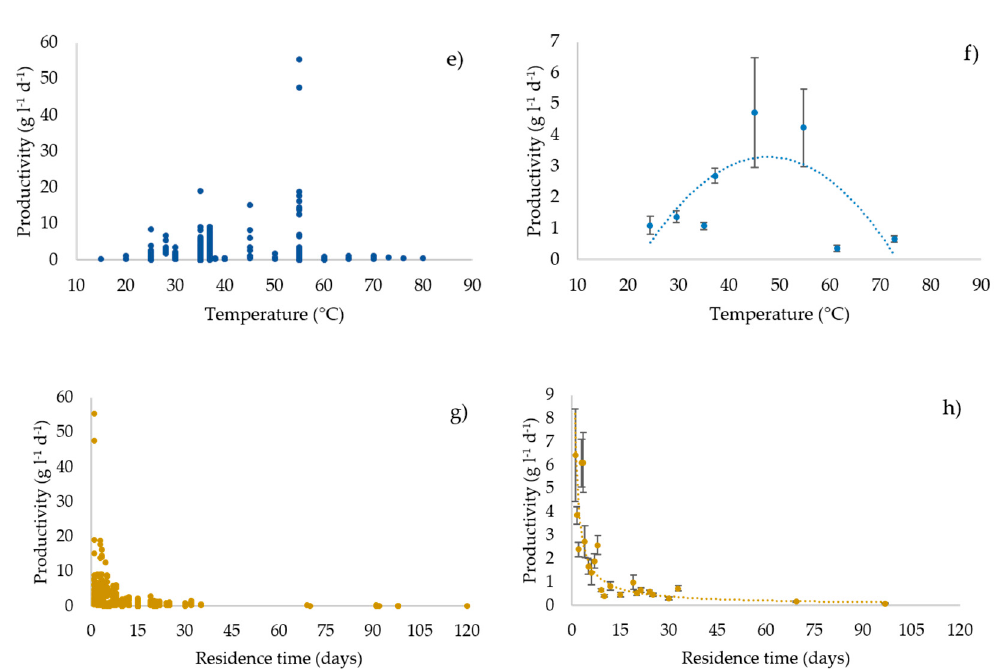
Figure 3. Relationships between productivity and operating parameters. ( a , c , e , g ) All the considered experiments. ( b , d , f , h ) Average values of experiments in each narrow range (width maximum 20%) of the operating parameters (error bars indicate the standard error) with second grade polynomial curve. The polynomial curve is only used to visualise the general trend, without any statistical significance.